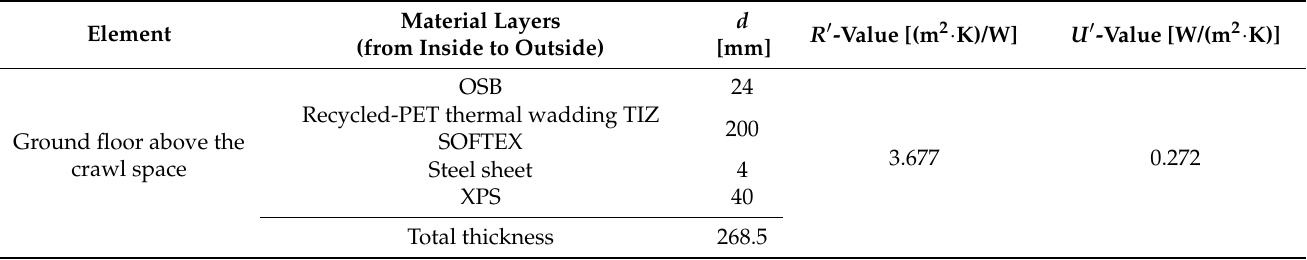
Table 2. Materials, thicknesses ( d ), adjusted thermal resistance ( 𝑅’ ) and adjusted thermal transmit- tances ( 𝑈’ ).